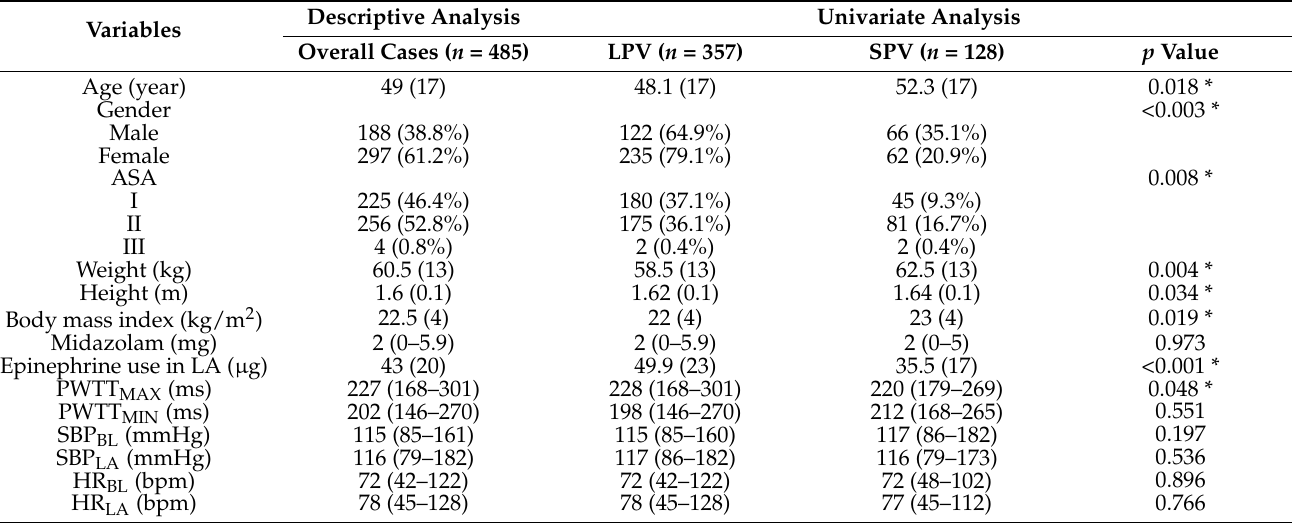
Table 1. Descriptive and univariate analysis of variables from recorded segments and clinical characteristics from overall reviewed